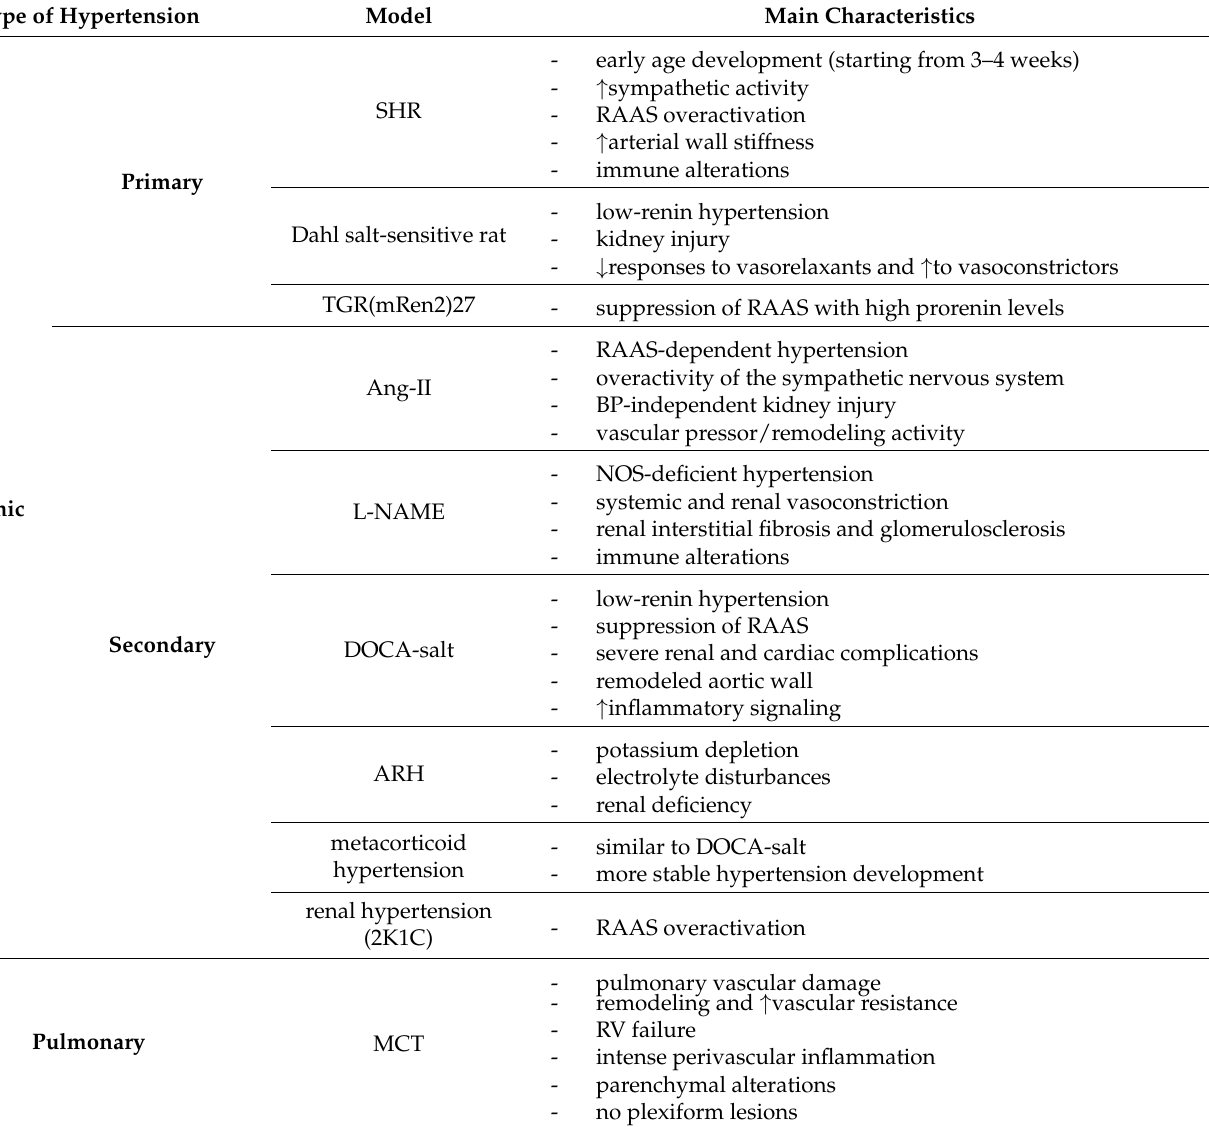
Table 1. Short list of characteristics of chosen models of systemic and pulmonary